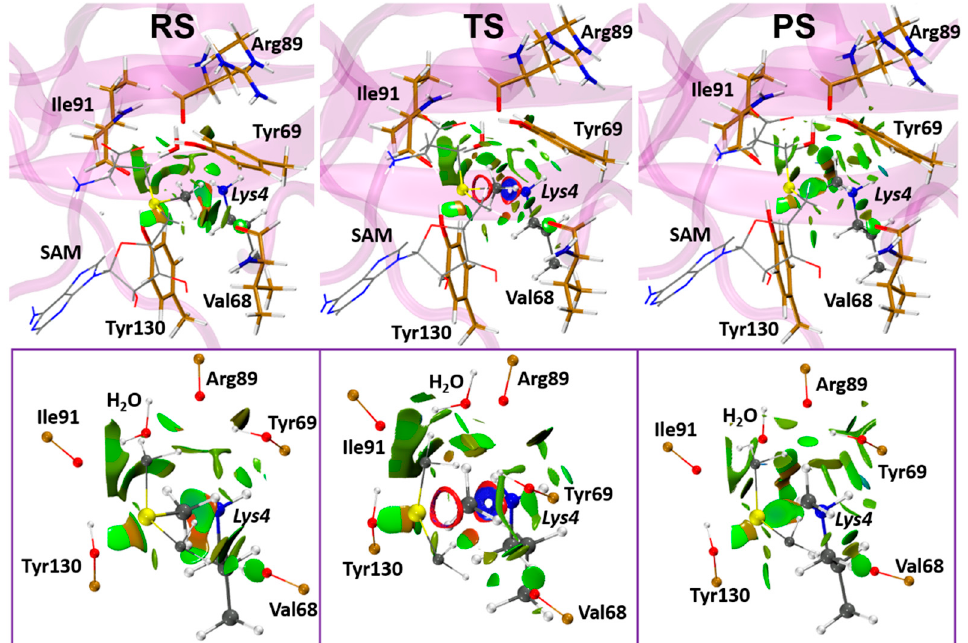
Figure 6. Graphic representation in real space of the non-covalent interactions taking place between the methyl group and the catalytic site along the reaction process. Below there is a simplified picture of the interactions where only the C=O moiety from backbone and C-O-H par of Tyr moieties are shown for the residues involved in this oxy-anionic ring (enzyme’s carbon ― orange; substrate and cofactor carbon ― gray; red ― oxygen; blue ― nitrogen; white ― hydrogen and the isovalue used as cutoff for the surface was defined at 0.5).